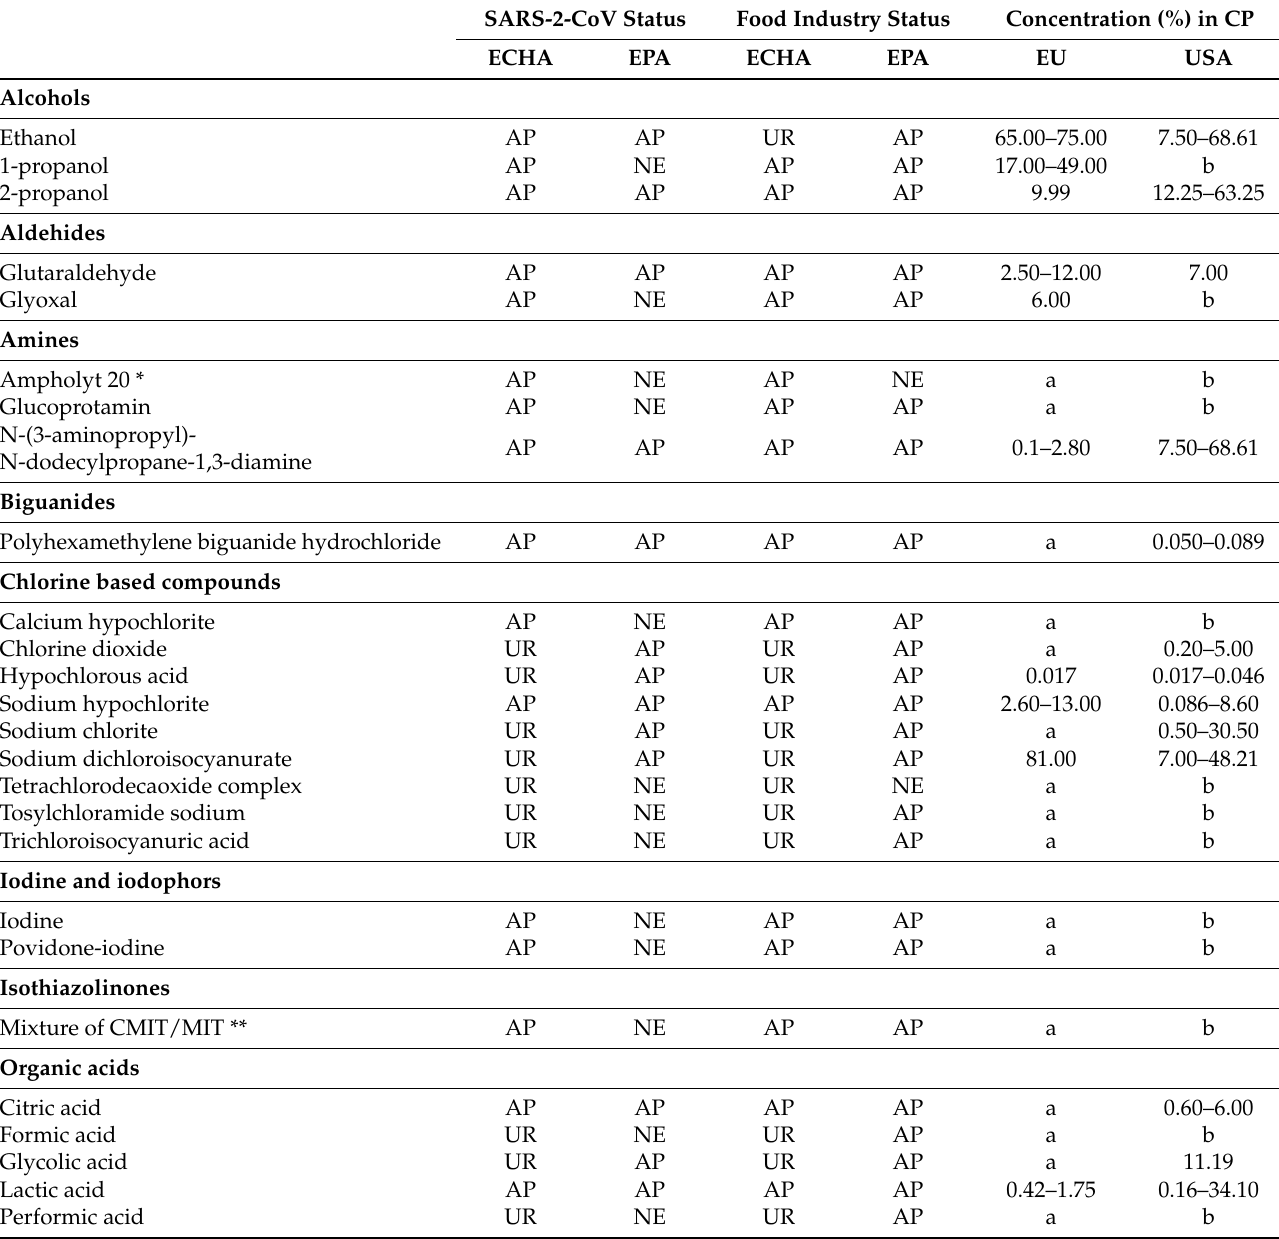
Table 2. Status of the substances against SARS-COV-2 according to The European Chemicals Agency (ECHA) and Environ- mental Protection Agency (EPA). CP: commercial products; AP: approved; UR: under review; NE: not evaluated. a: Substance not found in the formulation of commercial biocides authorized by ECHA to be employed in the food and feed areas (PT 4). b: Substance not found in the formulation of EPA authorised commercial biocides against SARS-CoV-2 (not area distinction). Compounds tagged as “under review” in ECHA column can be part of the formulation of authorized commercial products employed in some European countries if they are covered by their respective legislations [42]. Substances concentrations in commercial products available in the EU were obtained from the state members of Spanish [43] and Dutch [44] markets, both selected as reference markets by ECHA [42]. Substance concentrations in commercial products available in the USA were extracted from the Emergency Care Research Institute (ECRI) [45]. * N-C10-16-alkyltrimethylenedi- reaction products with chloroacetic acid. ** Mixture of 5-chloro-2-methyl-2H-isothiazol-3-one (EINECS 247-500-7) and 2-methyl-2H-isothiazol-3-one (EINECS